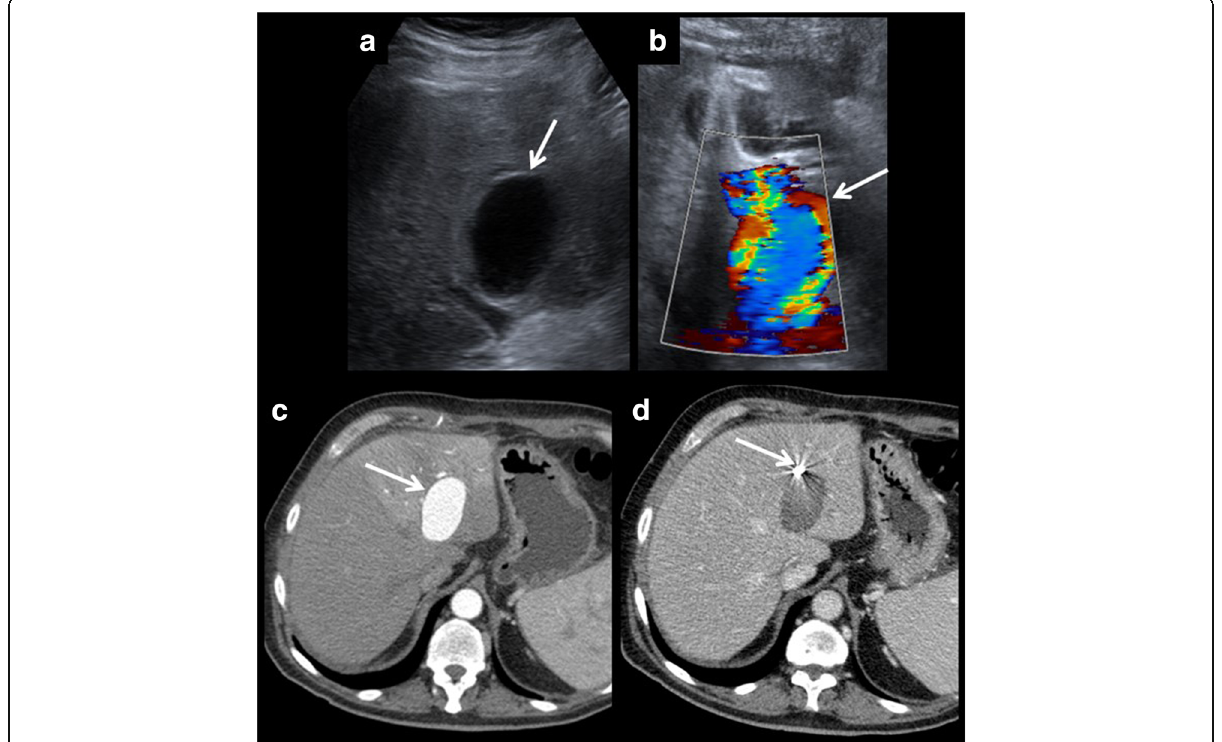
Fig. 7 Hepatic artery pseudoaneurysm. Pseudoaneurysms can be discovered using ultrasound ( a ). It shows a characteristics appearance in Doppler ultrasound, due to the turbulent forward and backward flow ( b ). Arterial phase CT shows arterial enhancement of the pseudoaneurysm ( c ). A coil is placed to block entering the blood and to prevent rupture ( d